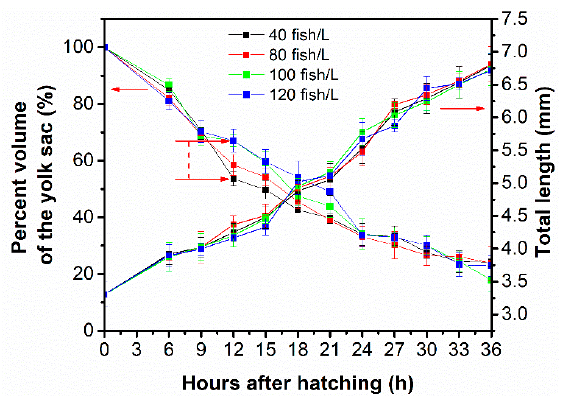
Figure 3. The percentage volume of the yolk sac and total length of striped catfish ( Pangasianodon hypophthalmus ) larvae samples at various stock density treatment levels and hours after hatching in endogenous stage, at mean temperature of 26.08 °C.